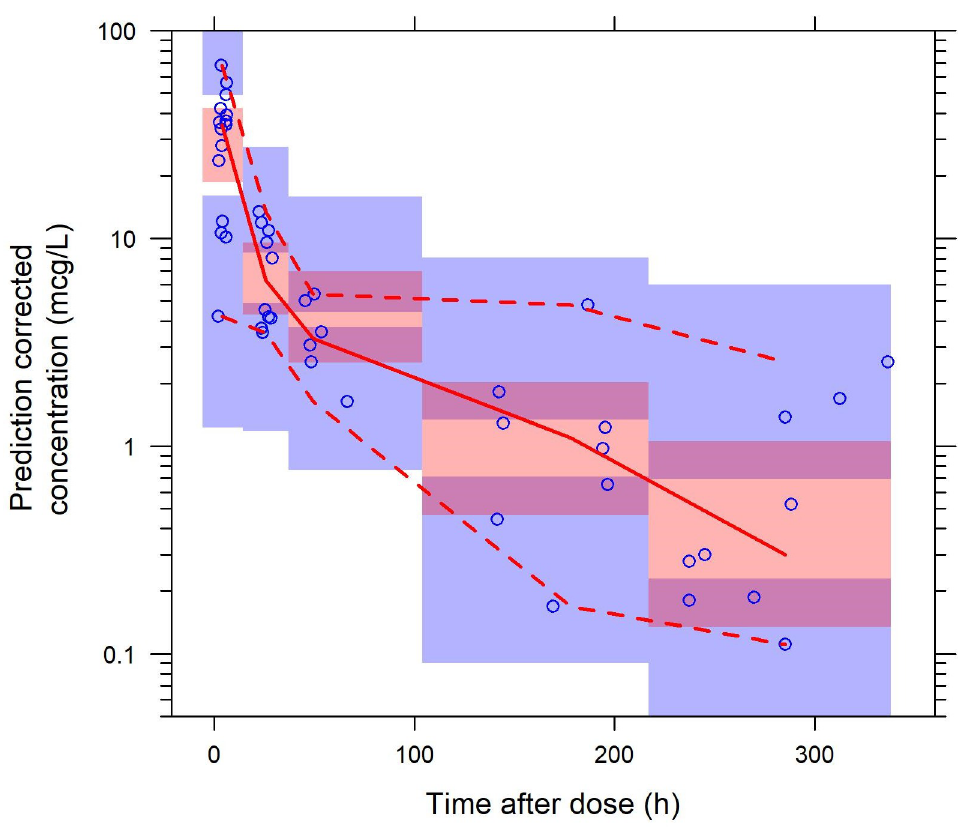
Fig 1. Prediction-corrected visual predictive check. The open circles are observed concentrations. The dashed lines are the 10 th and 90 th percentiles of the model predictions and the solid line is the 50 th percentile. The bands are the 95% CI of the percentiles of the model